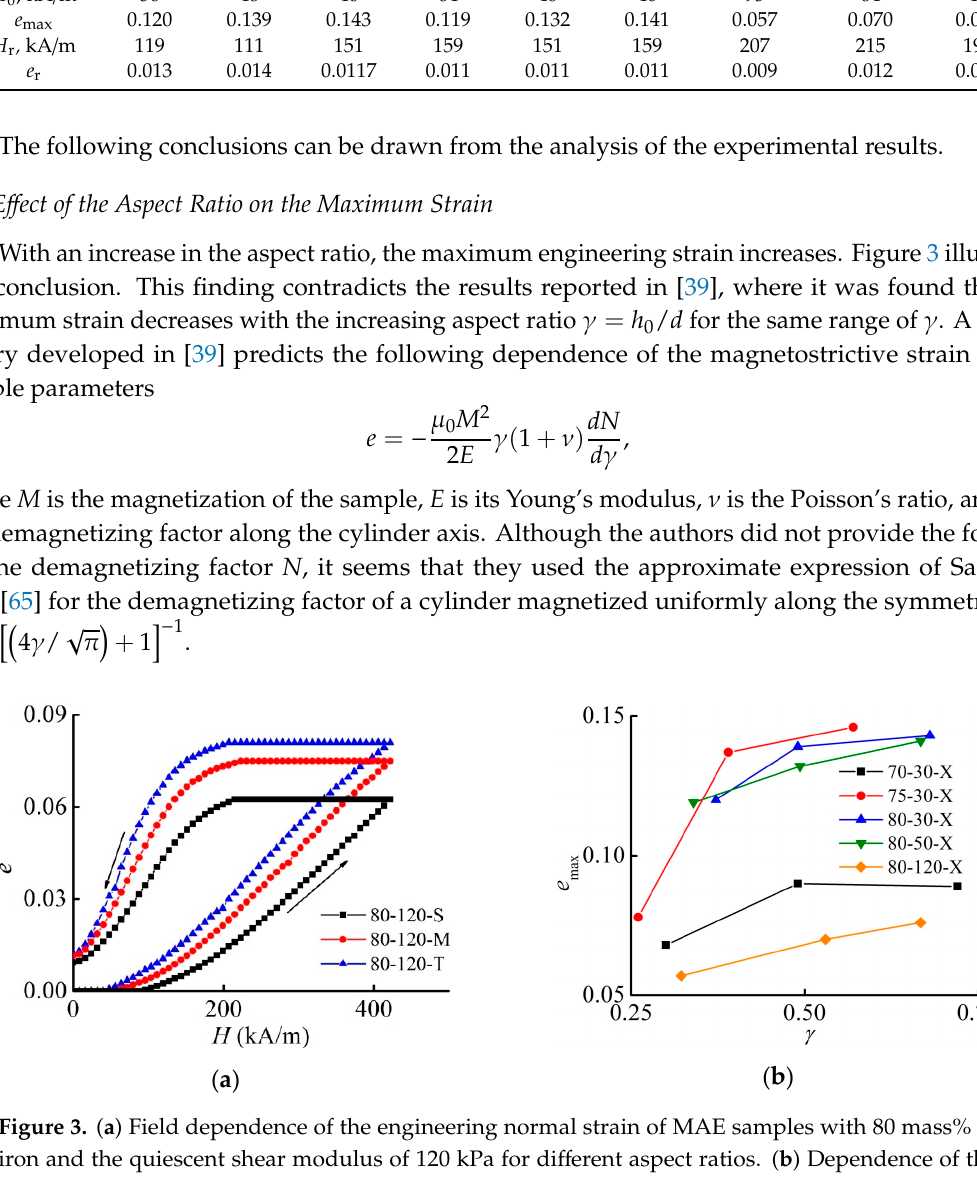
Table 3. Measurement results for MAE cylinders with 80 mass% of carbonyl iron.